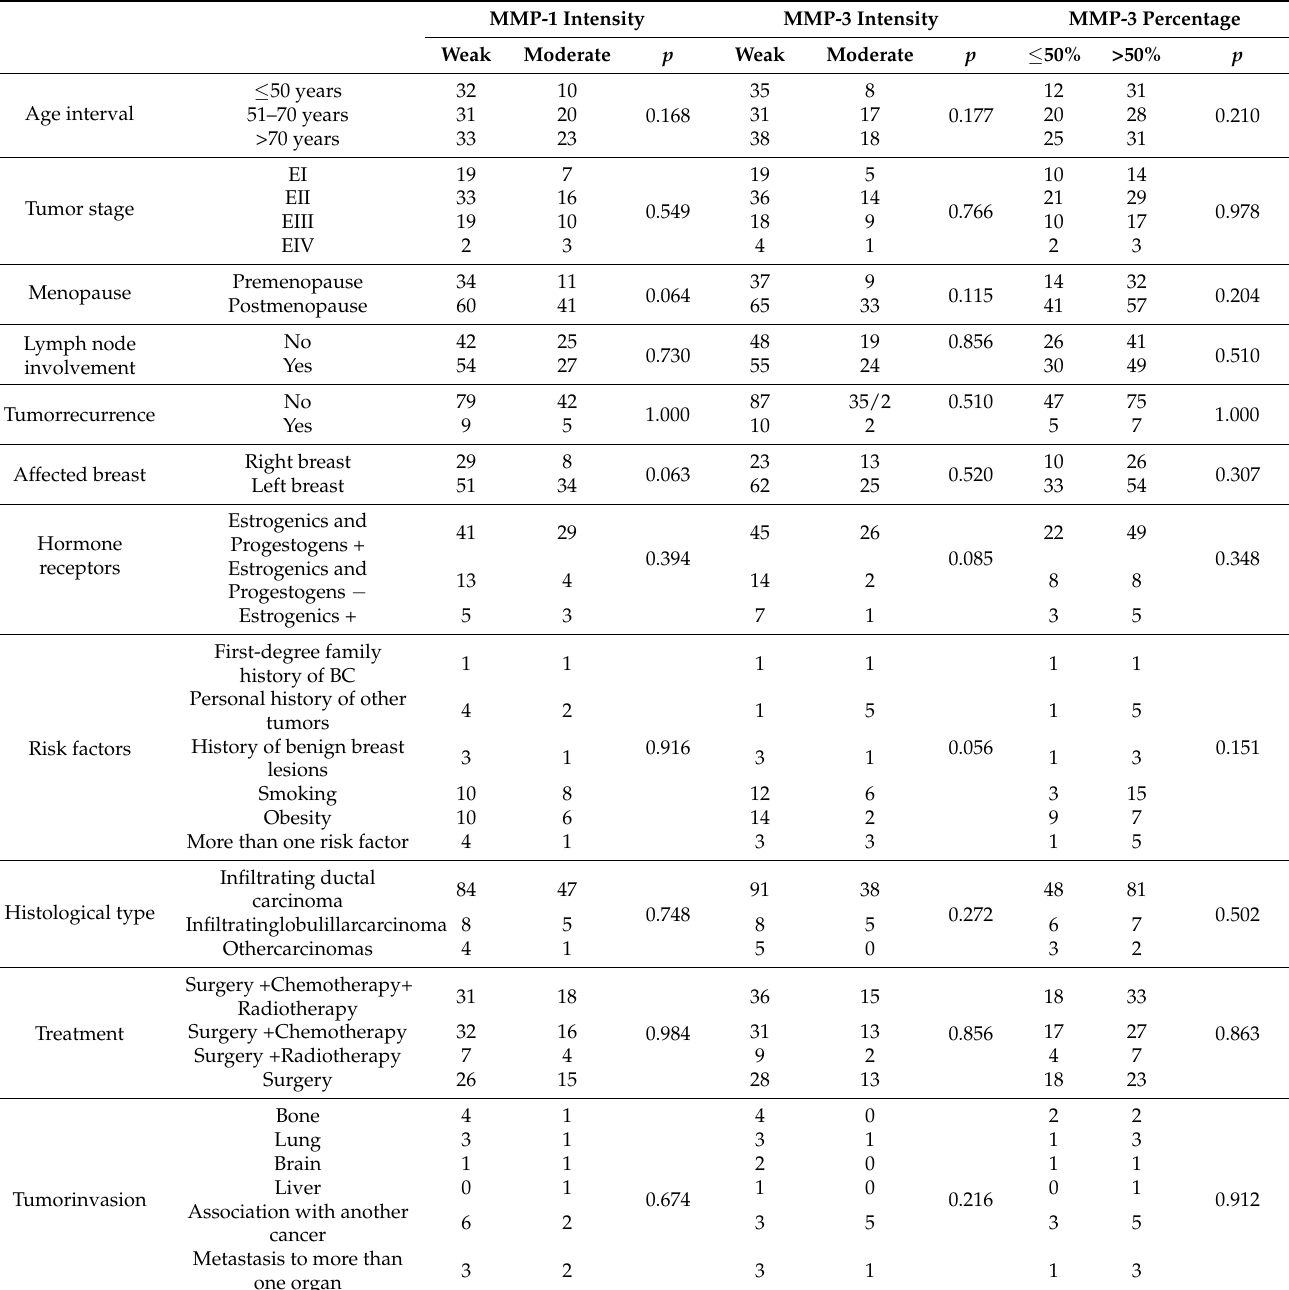
number of patients analyzed with cancer, we identified that MMP-1 staining intensity and MMP3 staining percentage and intensity were higher in postmenopause patients, in those with positive hormone receptors, and in the histological ductal carcinoma type (Table 3). Table 3. Statistical analysis between variables MMP-1 and MMP-3 expression and clinical–pathological